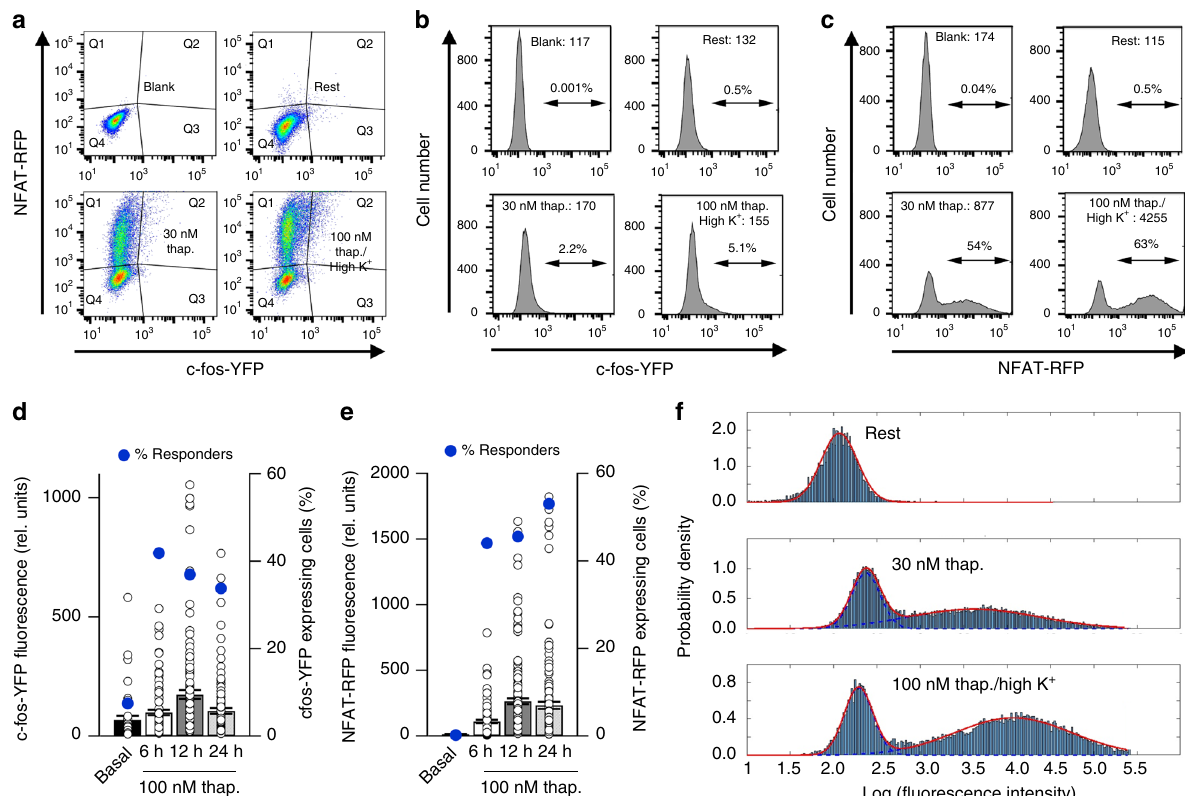
Fig. 5 Comparison of extent of co-expression of c-fos-YFP and NFAT-RFP in the same cells. a Representative fl ow cytometry plots of c-fos-driven YFP and NFAT-driven RFP expression in non-transfected cells (labelled Blank), transfected but unstimulated cells (labelled Rest), cells challenged with 30 nM thapsigargin and cells stimulated with 100 nM thapsigargin in high K + solution. Plots were divided into four sections (Q1 – Q4), representing high RFP expression (Q1), high RFP and YFP expression (Q2), high YFP expression (Q3) and low expression of both proteins (Q4). For blank, % cells in Q1 was 0.044, Q2 was 0.009, Q3 was 0.005 and Q4 was 99.9. For rest, % cells in Q1 was 0.46, Q2 was 0.1, Q3 was 0.63 and Q4 was 98.7. For 30 nM thapsigargin, % cells in Q1 was 50.9, Q2 was 2.16, Q3 was 0.32 and Q4 was 46.6. For 100 nM thapsigargin in high K + solution, % cells in Q1 was 60.4,